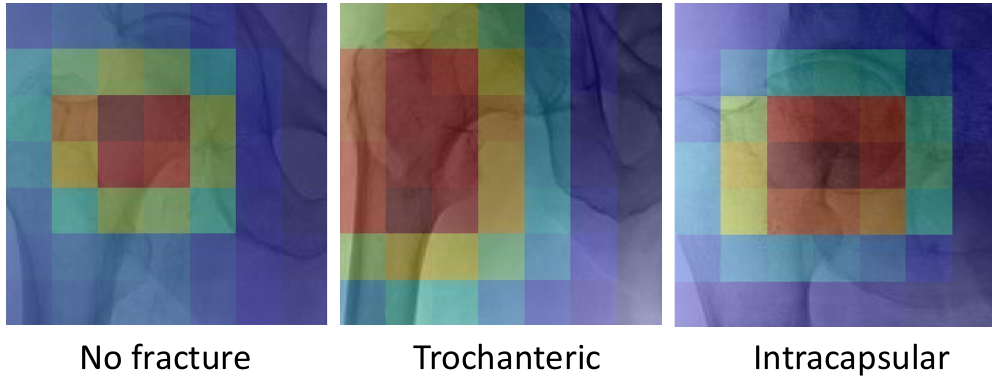
Figure 5. Activation maps for representative examples for No fracture, Trochanteric and Intracapsular classes. Dark red implies regions of high contribution and dark blue regions of low contribution. A custom python code based on the code provided by Selvaraju et al. 41 downloaded from github (https:// github. com/ ramprs/ grad- cam) was used to generate the activation